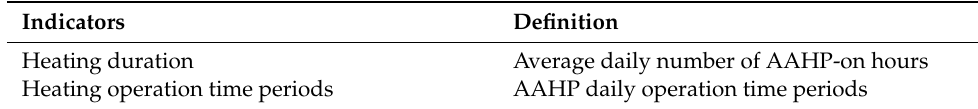
Table 4. AAHP heating pattern characteristic indicators.